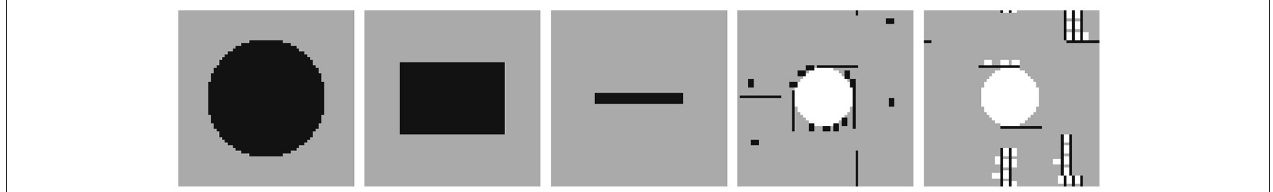
FIGURE 2 | Possible shapes of building units (size not to scale); from left to right: Spherical, platy, or needle-like, and composites. Black and white to indicate equal charge for the composites.